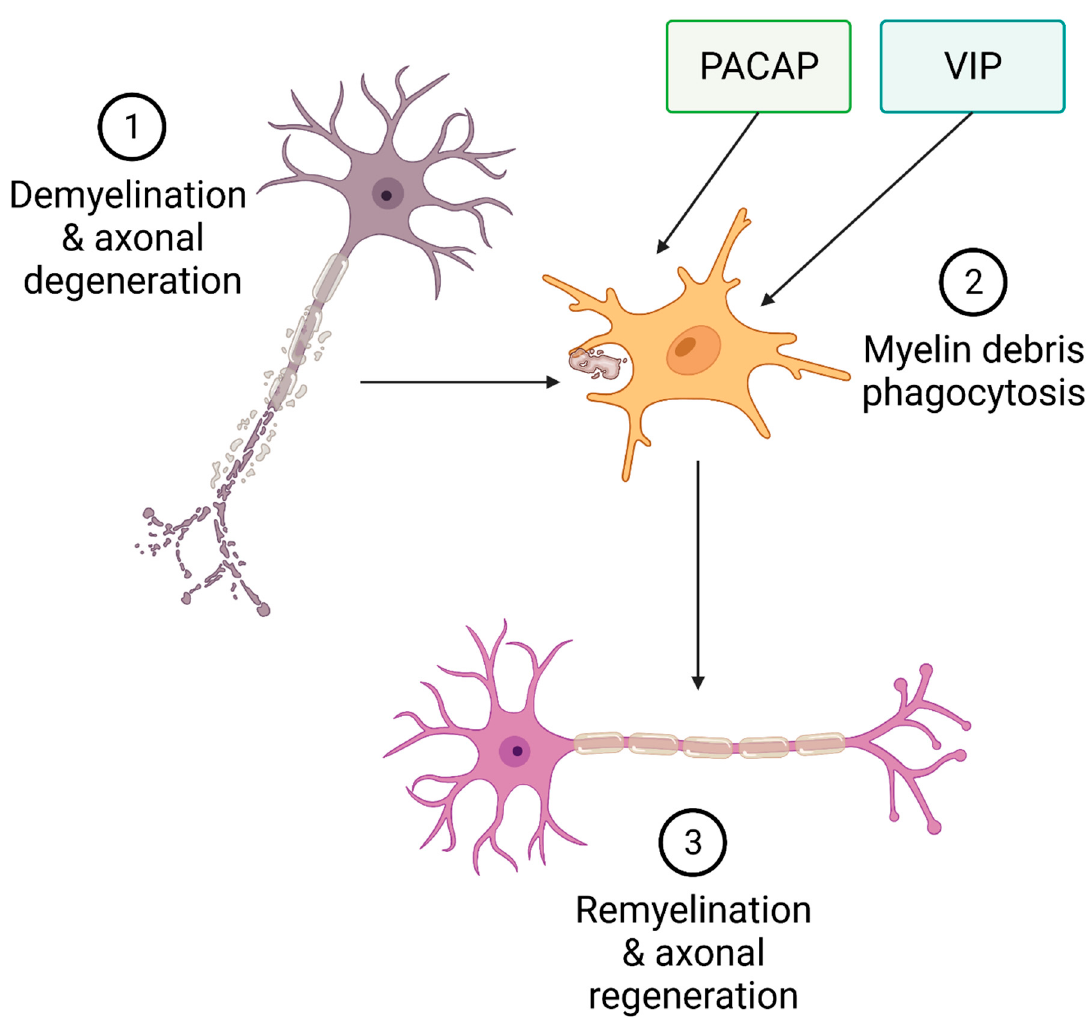
Figure 3. Proposed model for PACAP and VIP prophagocytic activities in microglia. In this sim- plified model, myelinated fibres of the CNS undergo immune attack, resulting in myelin degradation, axonopathy, and neuronal death ( 1 ). Both PACAP and VIP activate microglia to promote phagocytosis of myelin debris ( 2 ), creating a permissive microenvironment that allows myelin repair ( 3 ).